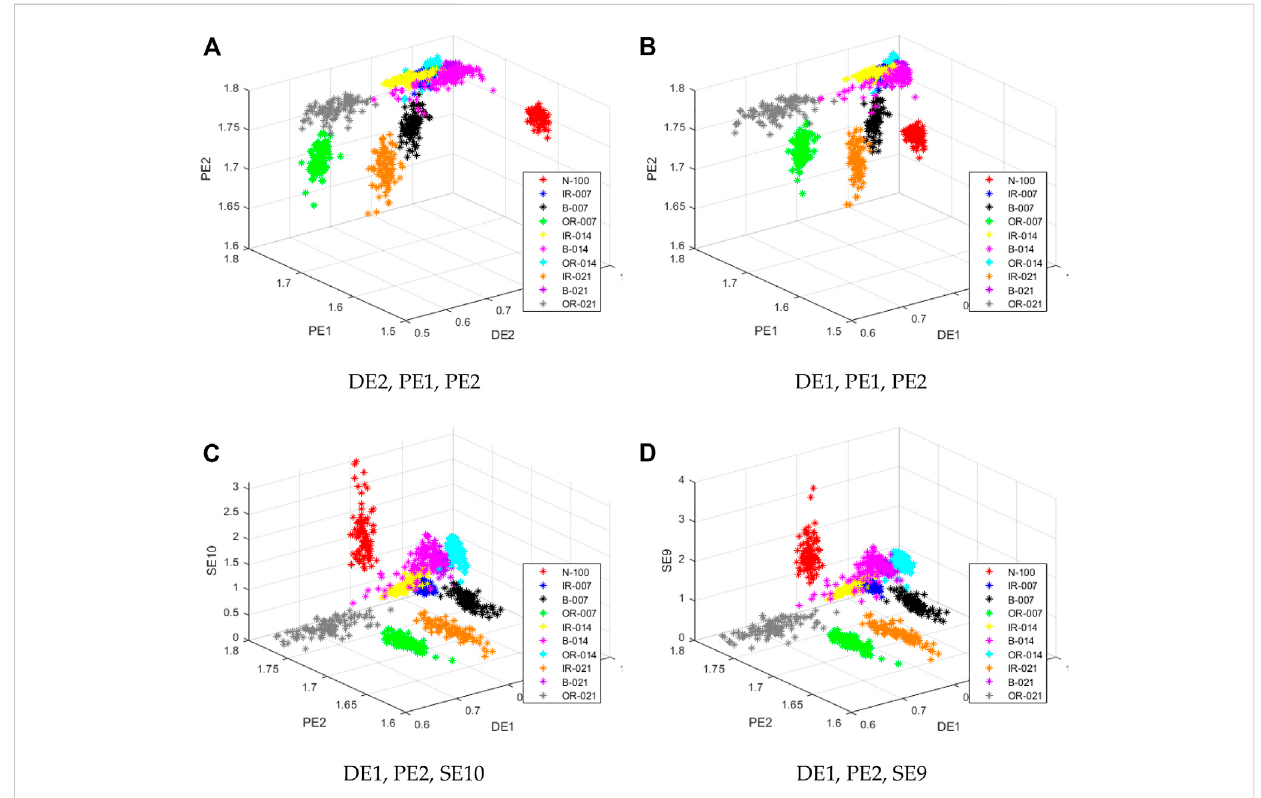
FIGURE 5 The distribution of features for the four best combinations of recognition results: (A) DE2, PE1, PE2 ; (B) DE1, PE1, PE2; (C) DE1, PE2, SE10; (D) DE1,PE2,SE9.